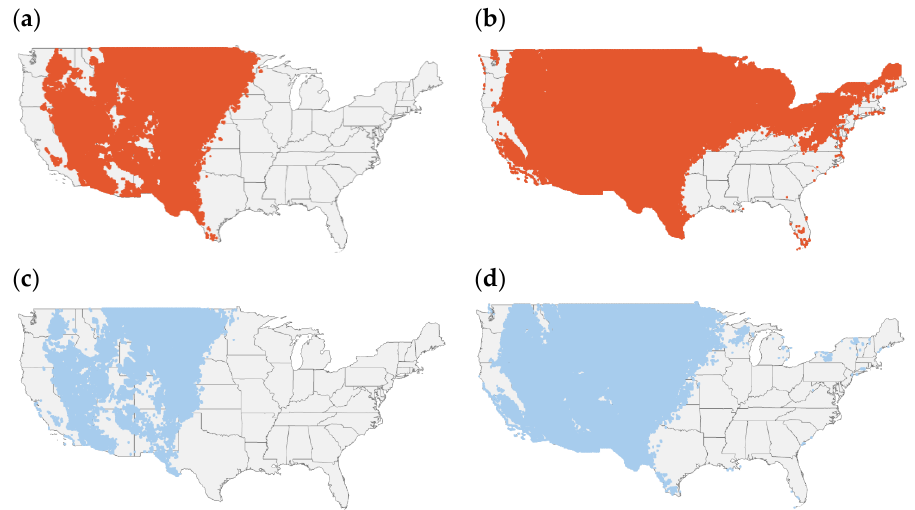
Figure 4. Thirty-year U.S. precipitation below 10th percentile during months of November and December. ( a ) 10 mm rainfall in December ( b ) 25 mm rainfall in December ( c ) 10 mm rainfall in November ( d ) 25 mm rainfall in November.